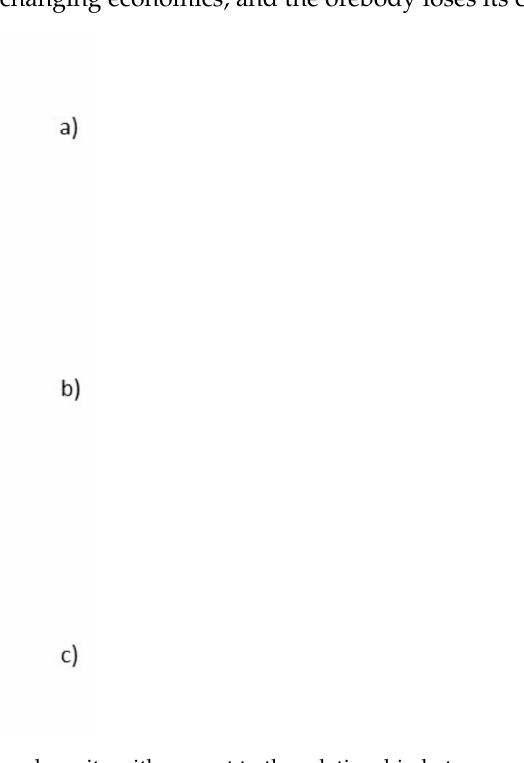
Figure 5. Three different types of ore deposits with respect to the relationship between ore and waste blocks: ( a ) compact ore body, ( b ) ore blocks isolated in waste, and ( c ) waste isolated in ore. Red: ore blocks above the cutoff, white: blocks below the cutoff